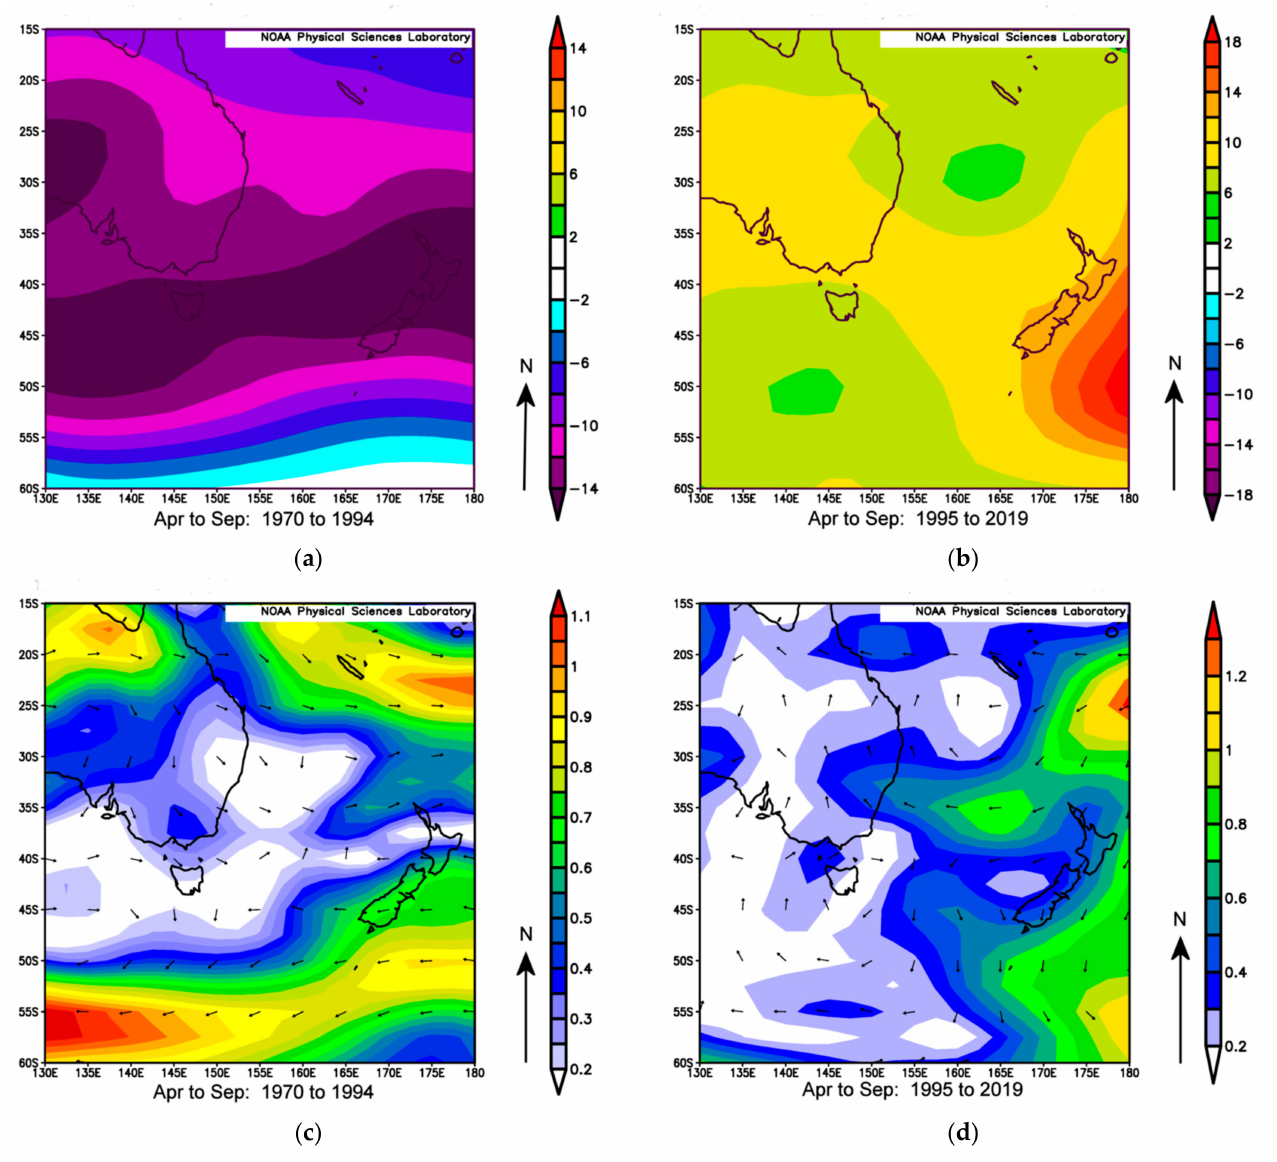
Figure 8. ( a ) 300 hPa geopotential height (m) composite anomaly April–September 1970–1994, ( b ) 300 hPa